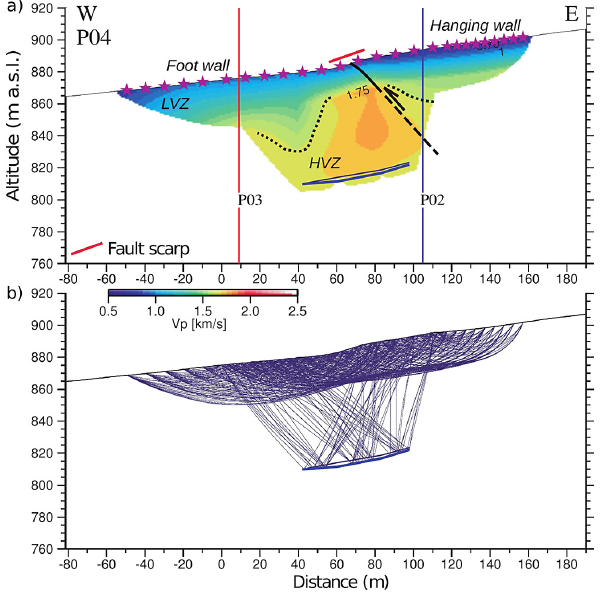
Figure 6. Results of seismic profile P4. (a) Final velocity model including the inverted reflector (blue line). Stars represent shot po- sitions. Zero distance represents position of the first geophone along the profile. Black line represent the SRF derived from paleoseismo- logical studies (Vargas and Rebolledo, 2012), while dashed black lines are inferred structures related to the SRF. Dashed red line rep- resents shallow sedimentary units. The intersections between P4 with profiles P3 and P2 are also indicated (see Fig. 2). (b) Asso- ciated ray paths.